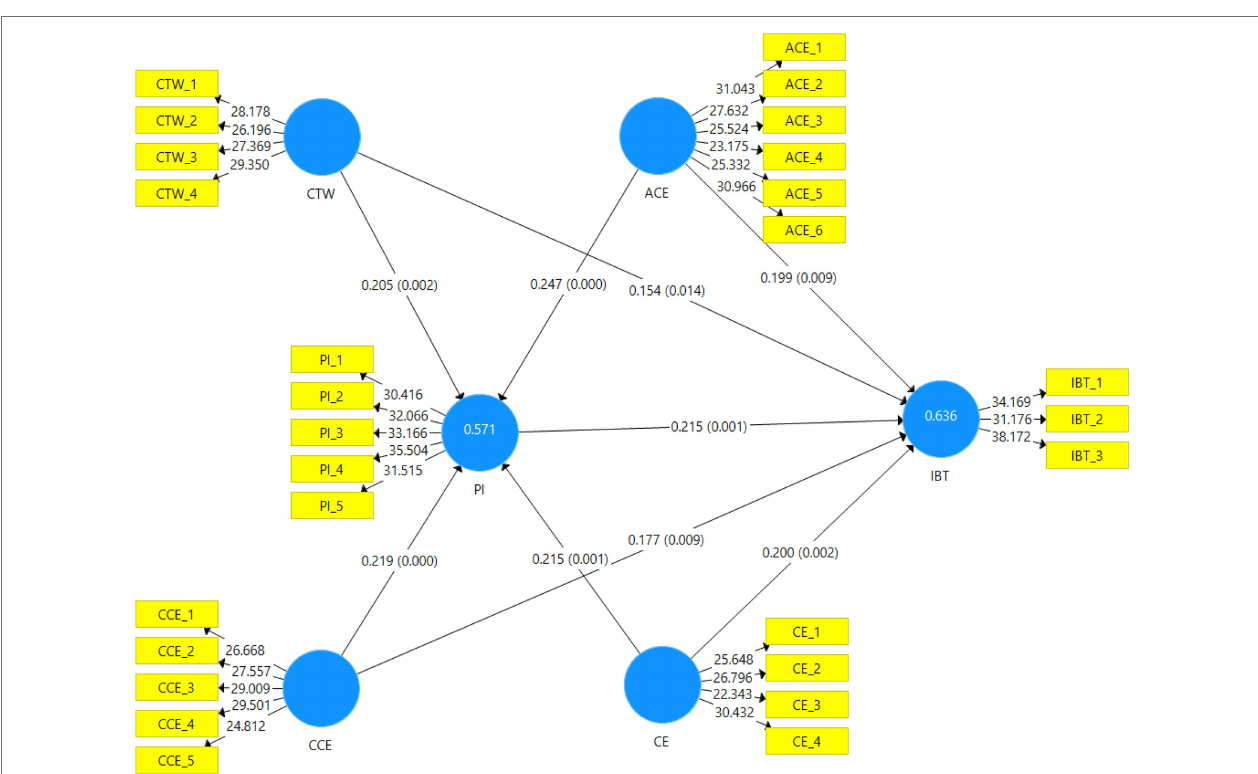
FIGURE 3 | Graphical representation of the structural model.